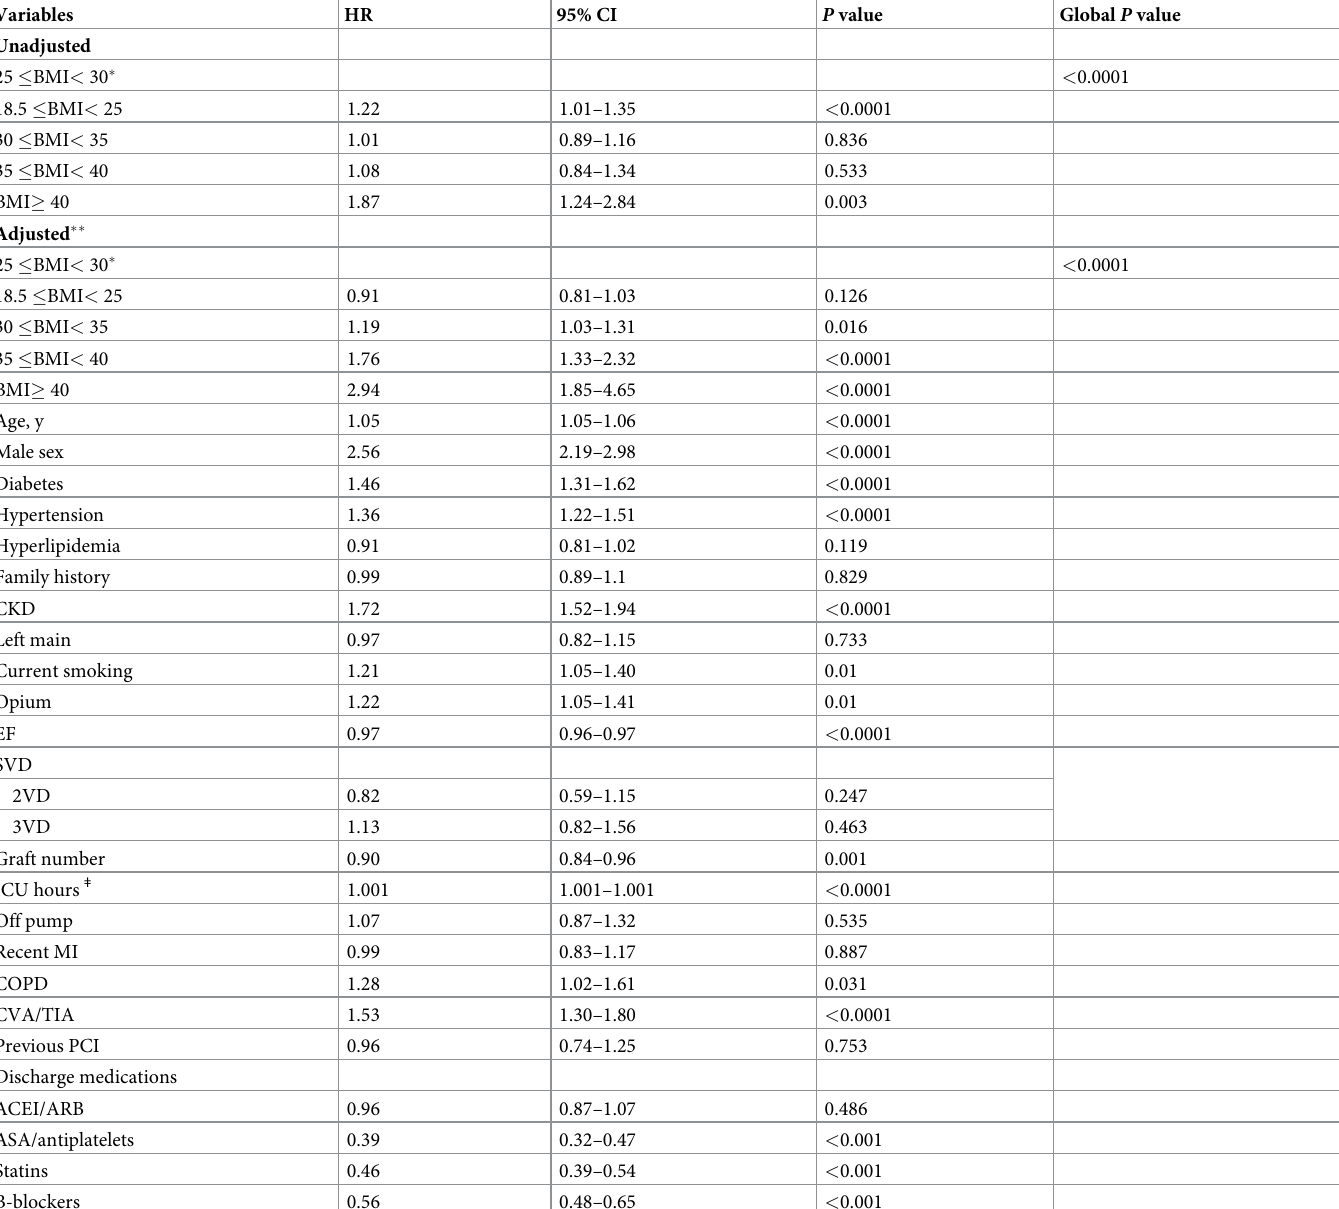
Table 2. Effects of the different levels of BMI on 5-year mortality after isolated coronary artery bypass graft